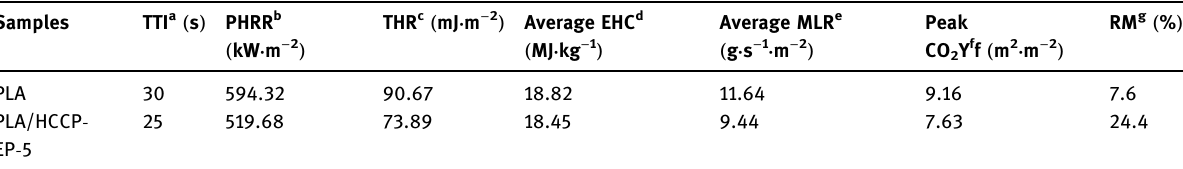
a Time to ignition; b Peak heat release rate; c Total heat release; d Average e ff ective heat of combustion; e Average mass loss rate; f Peak CO content; g Residual